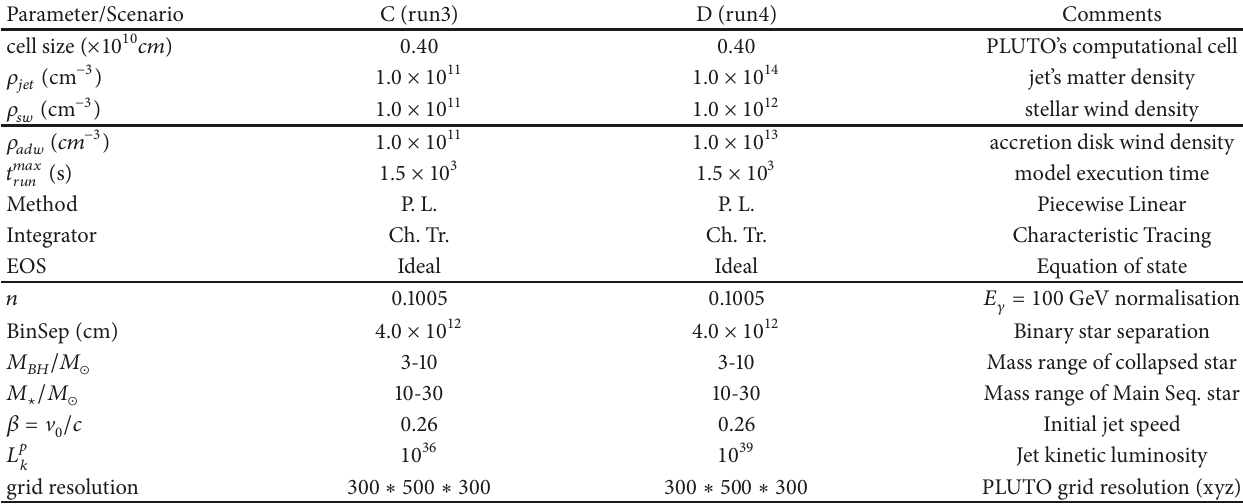
Table1: ScenarioC(run 3 )hasartificiallyacceleratedprecession,whilescenarioD(run 4 )hasallthedensitiesofthesystemincreasedbyafew orders of magnitude, in order to account for a higher jet-mass flow-rate(jet’s kinetic luminosity). The parameter 𝑛 refers to a “normalization” process that equates the results of two different methods of 𝛾 -ray emission calculations, one applied for energies above 𝐸 𝛾 =100 GeV and the other below this